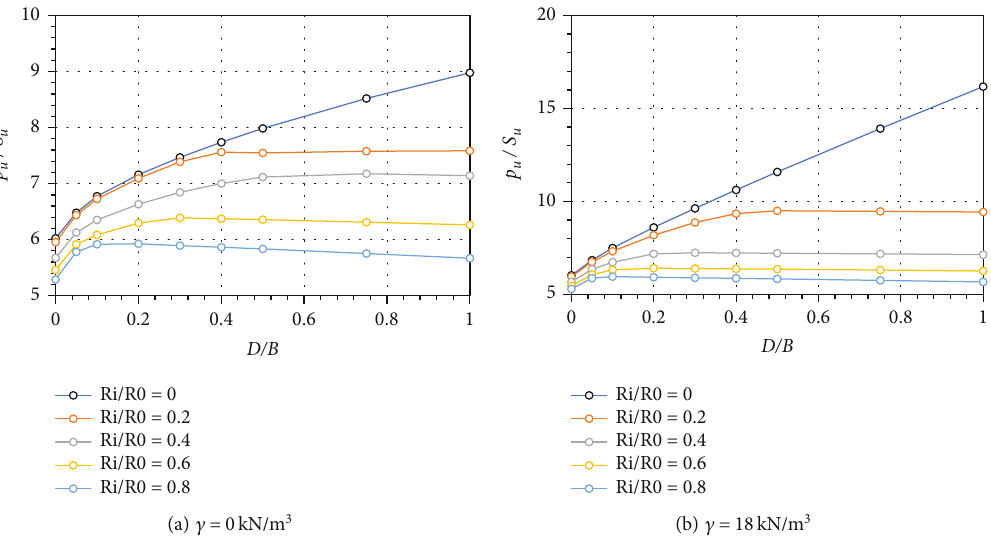
Figure 11: Variation curves of the bearing coe ffi cient versus D / B under di ff erent soil unit weights.